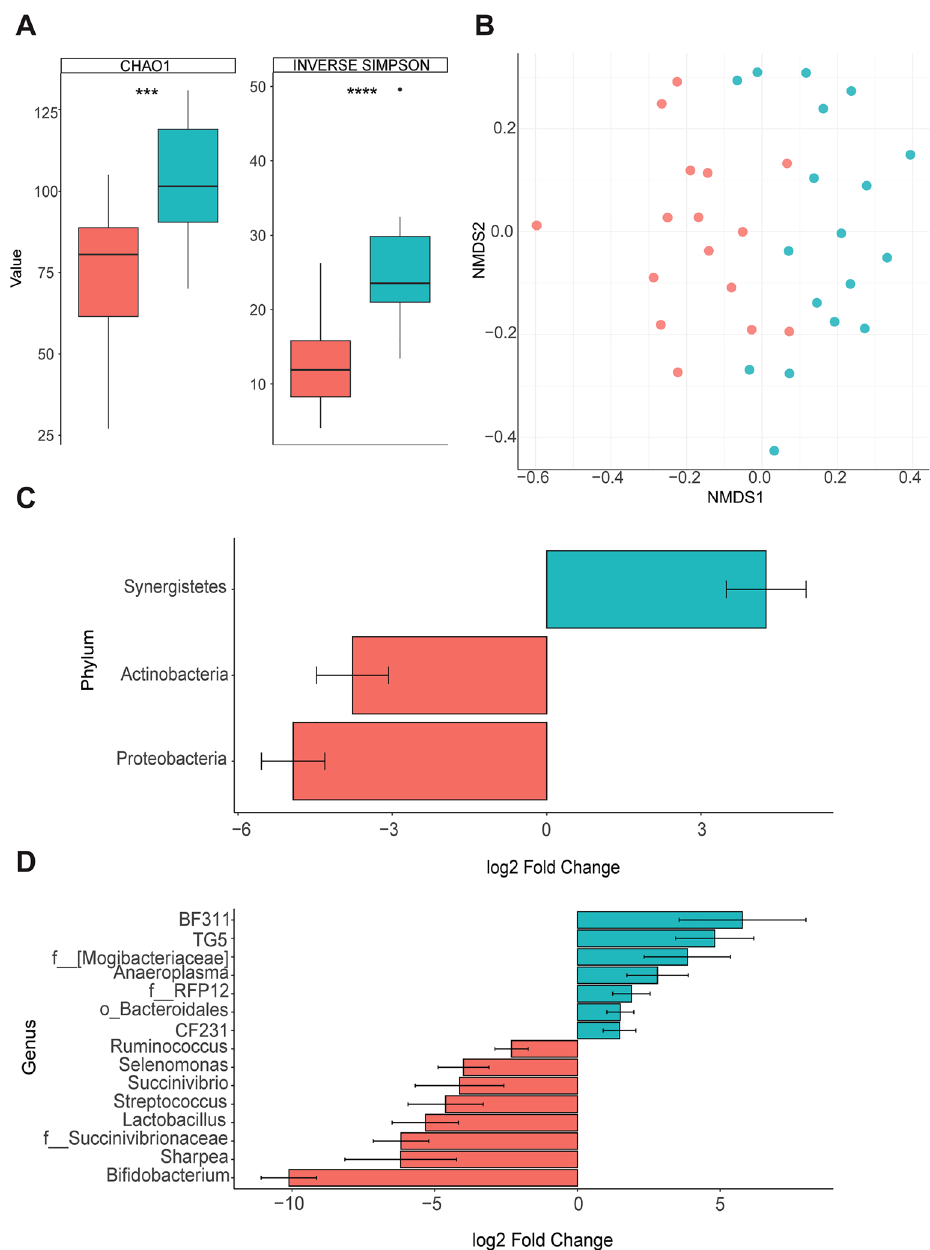
Figure 1. Measures of ( A ) Chao1 and Inverse Simpson alpha diversity and ( B ) Bray Curtis dissimilarities, and the Log2 fold change difference between significantly different (FDR P -value < 0.05) ( C ) phyla and ( D ) genera in the rumen fluid of control- (red) and carrot-fed (blue) lambs. Bray Curtis dissimilarities indicate separation ( P = 0.01; PERMANOVA) of the rumen microbial community structure, where each dot represents one lamb. Significant differences are indicated by asterisks ***( P ≤ 0.001) and ****( P ≤ 0.0001). Positive fold change indicates greater abundance of the microbe in the rumen microbial community of carrot-fed lambs, whereas a negative fold change represents greater abundance of the microbe in control-fed